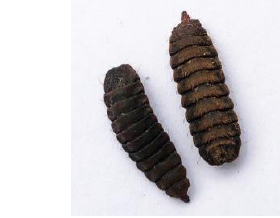
Figure 8: Prepupae of Black soldier fly extracted from waste bin (after cleaning)